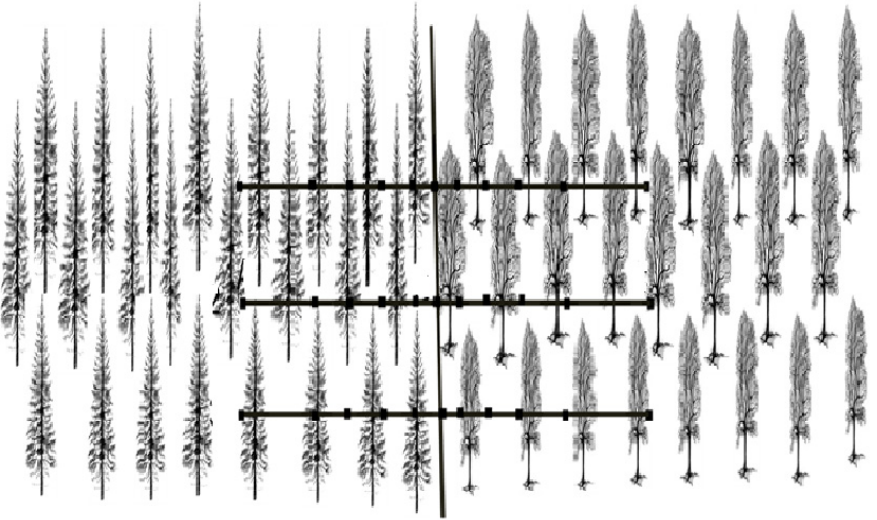
Figure 1. Sketch of the transboundary experimental design. The three transect lines run from the center of the Douglas ‐ fir plot (18 m from the boundary) to the boundary and then to the center of the beech plot (18 m from the boundary).